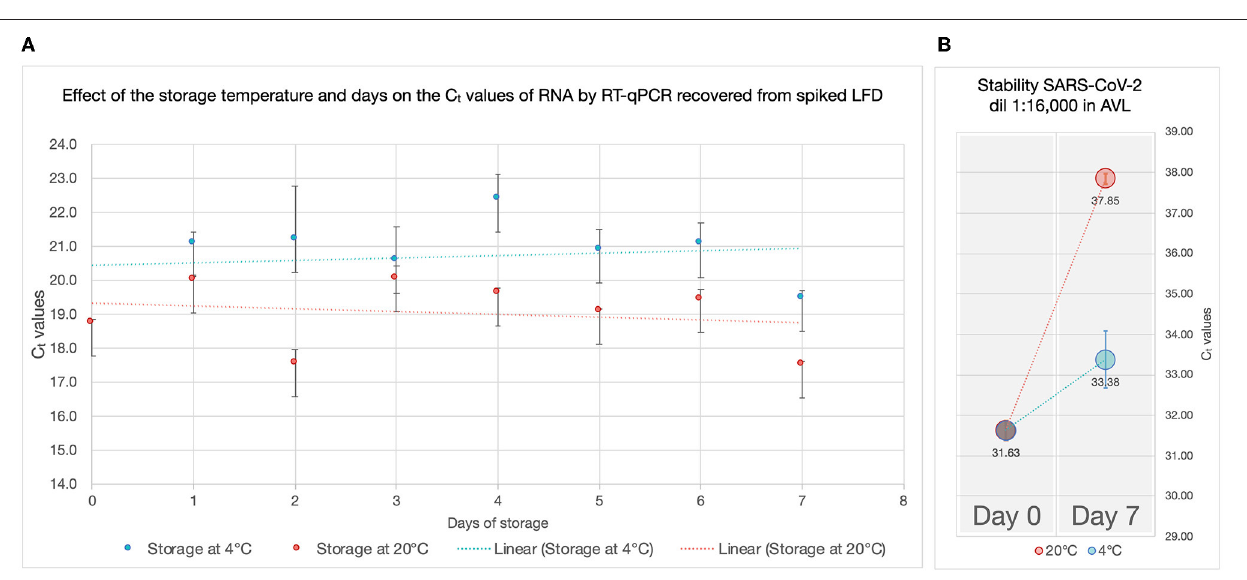
RADTs stored at 4 ◦ C and two at 20 ◦ C after addition of buffer AVL and extracted after 2 and 7 days. The alignment of the sequences showed the perfect alignment with the sequence of the Human SARS-CoV-2 variant Alpha (lineage B.1.1.7, isolate England/MIG457/2020) (17, 18) used for spiking the RADTs ( Figure 4